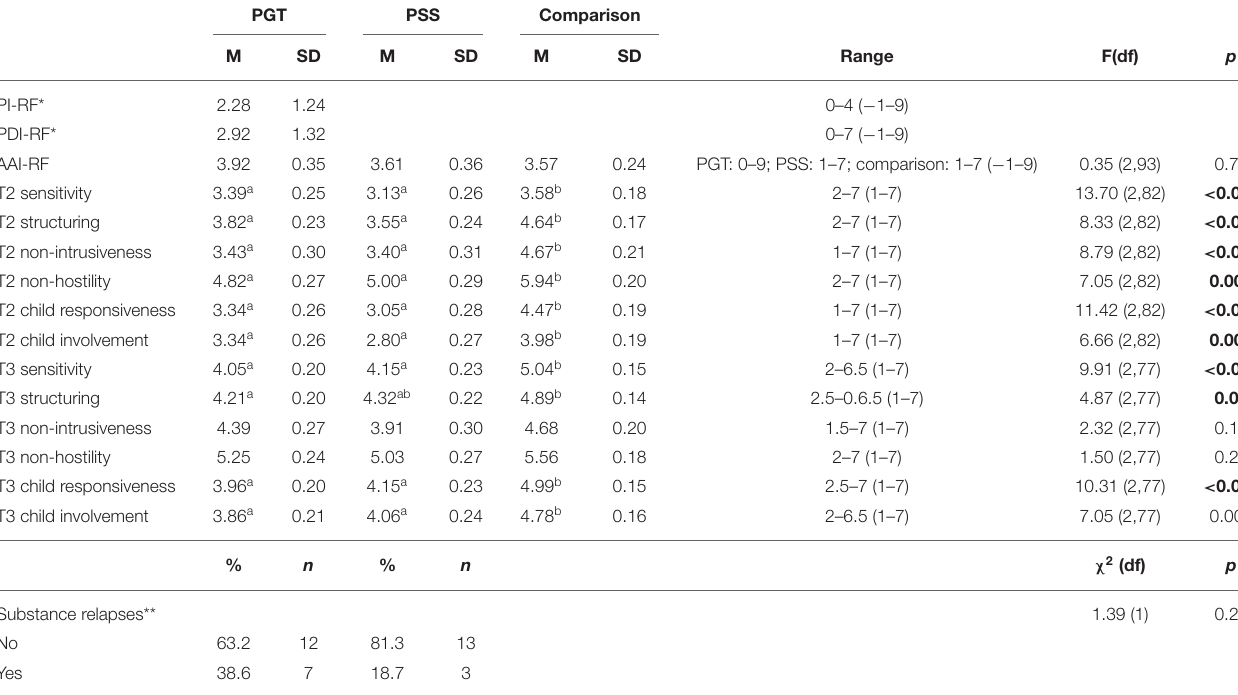
TABLE 1 | Means, standard deviations, ranges, and group differences in study variables. PGT PSS